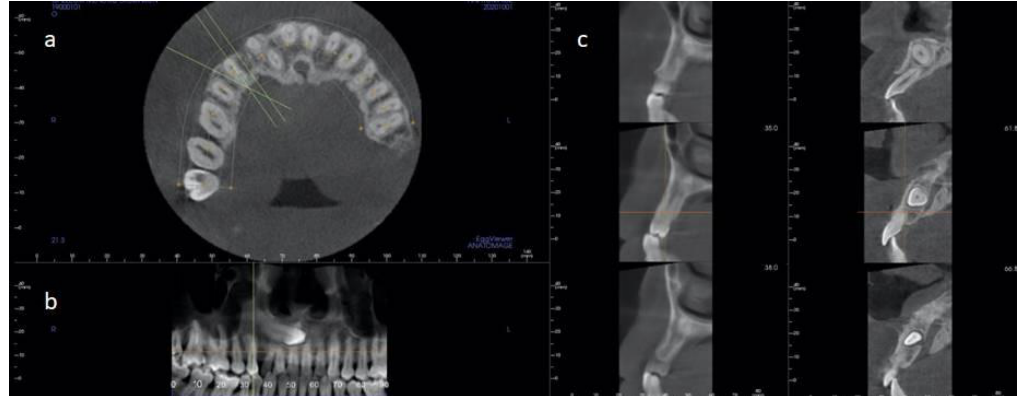
Figure 2. Case 2 CT-Scan images. ( a ) Axial section. ( b ) Image analogous to a panoramic radiography. ( c ) Sagittal sections show the impacted canine and its relationship with the adjacent teeth. show the impacted canine and its relationship with the adjacent